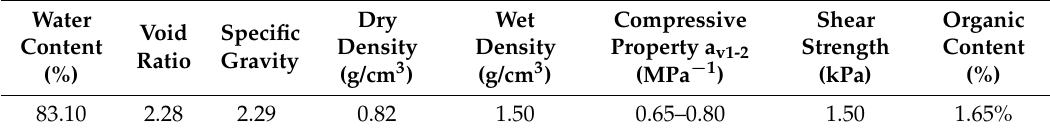
Table 1. Physical properties of dredger